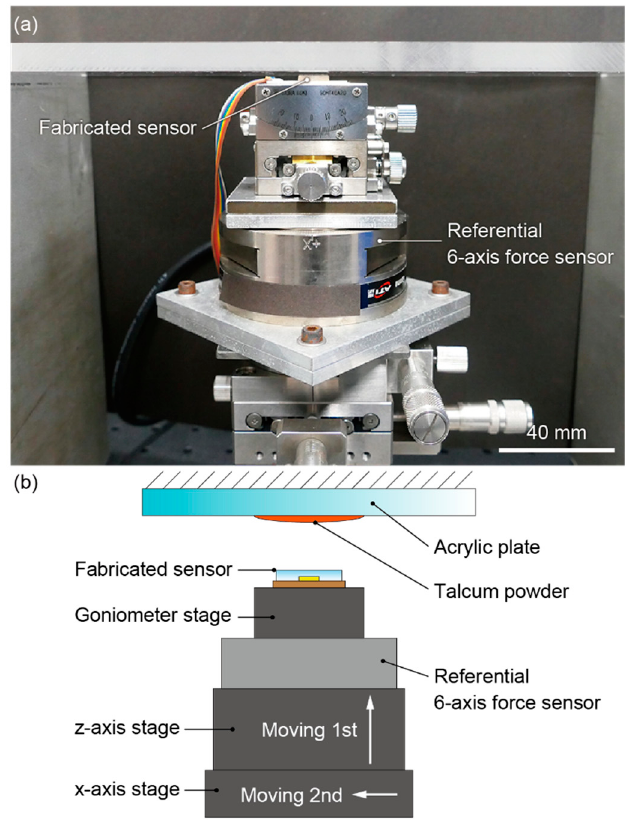
Figure 7. ( a ) Photograph and ( b ) schematic image of the experimental setup.